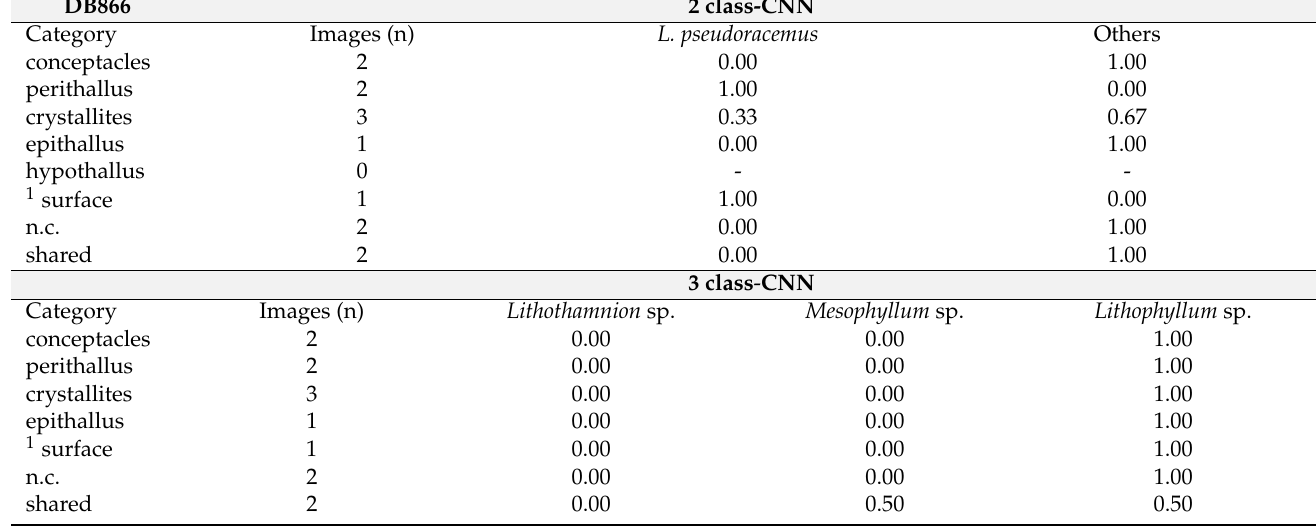
Table 6. The Class Share of the sample DB866 was reported for each assigned category (rows) and class (columns). The total number of SEM images in every predicted class of the three models is listed. Images not assigned to a category (n.c.) and showing more than one category (shared) are also